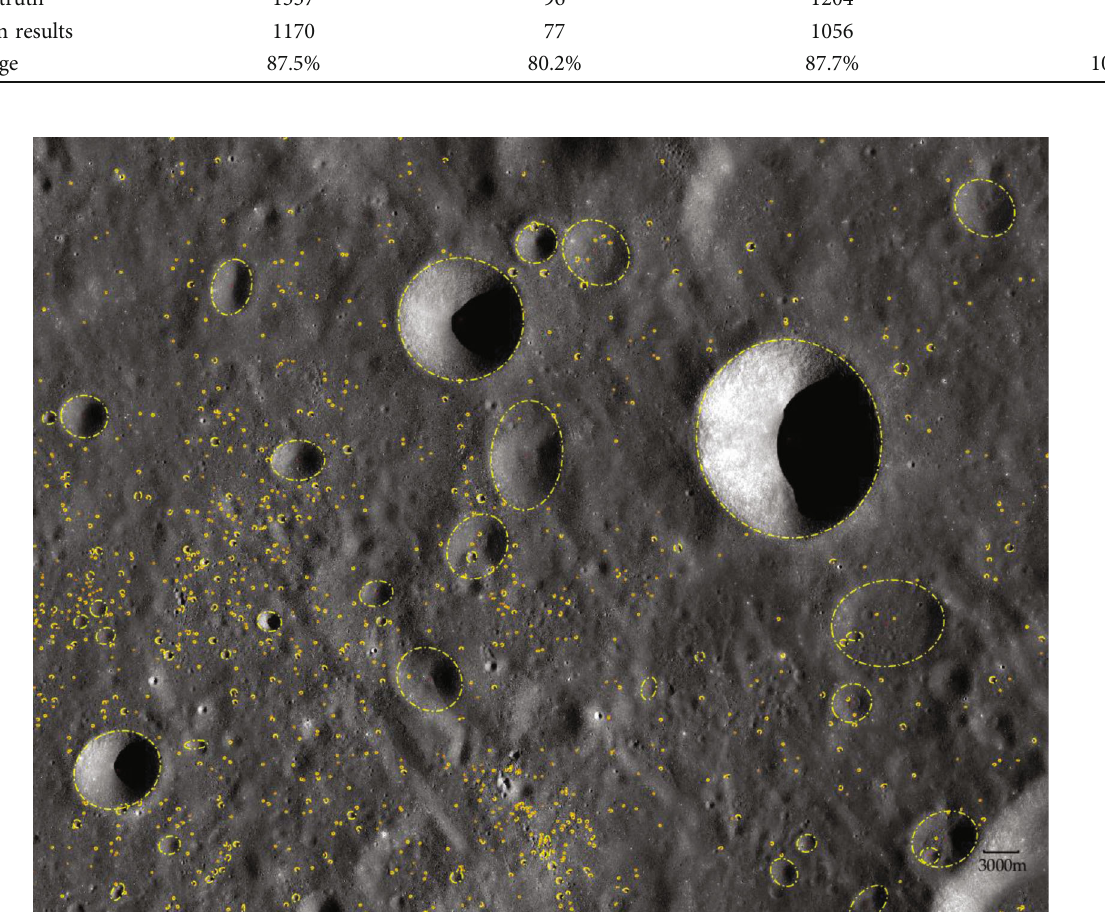
Figure 11: Crater detection